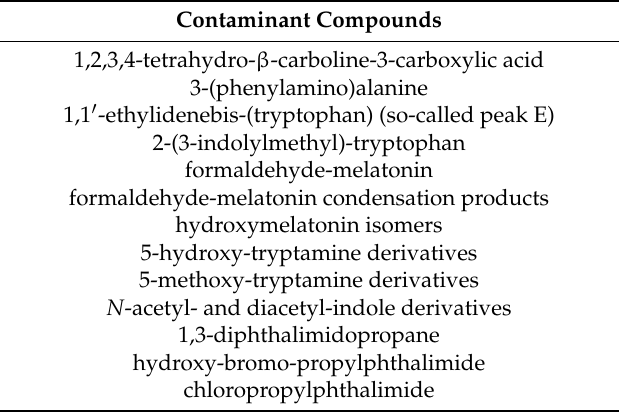
Table 4. Common contaminants in synthetic melatonin preparations.